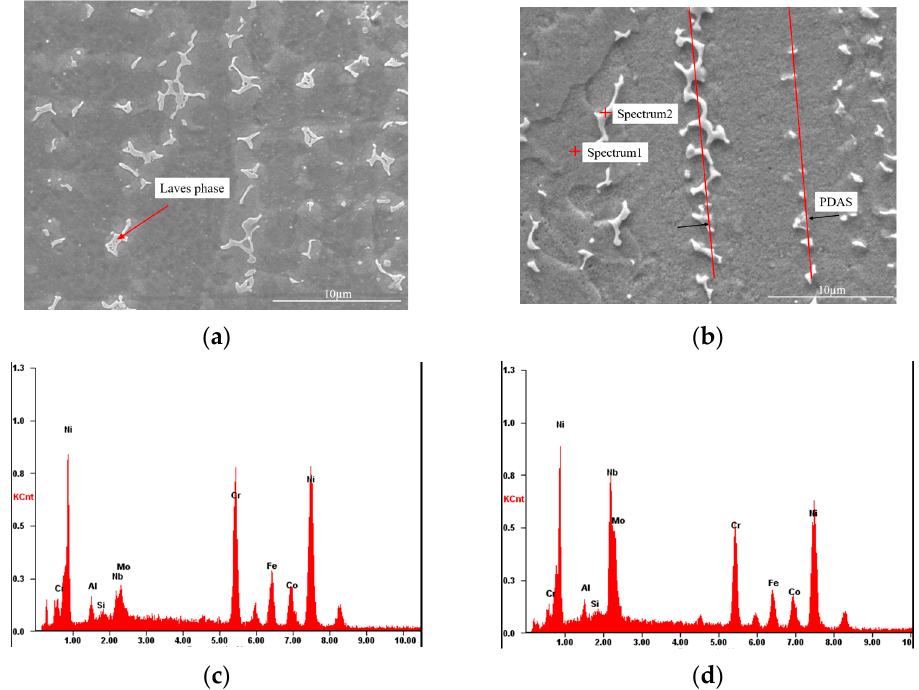
Figure 8. SEM photo of powder deposition samples. ( a ) SEM photo of the deposited sample of new powder (H0); ( b ) SEM photo of the deposited sample of four times recovered (H4); ( c ) Sample EDS; ( d ) Laves phase EDS.